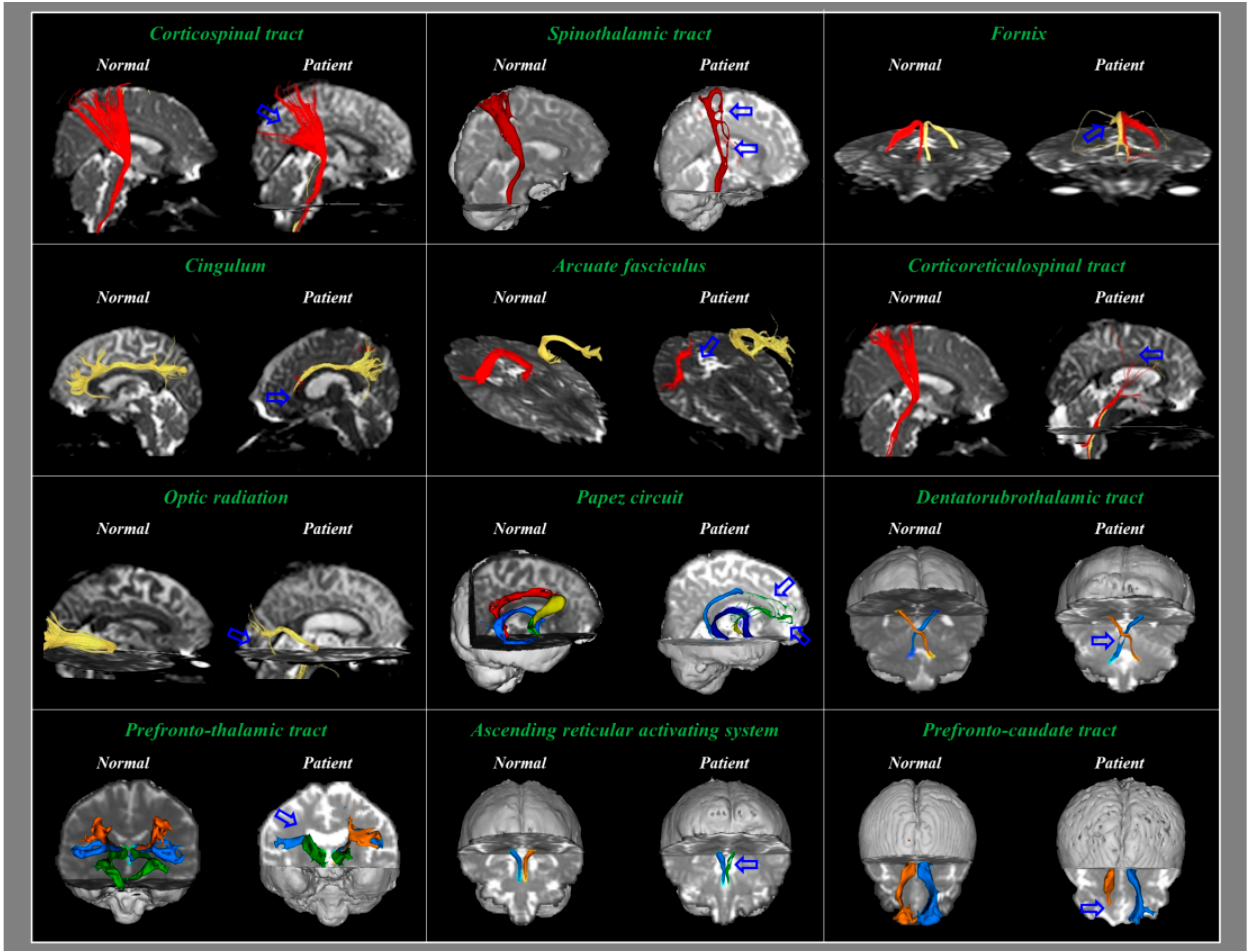
Figure 4. Traumatic axonal injuries (arrow) of various neural tracts (right corticospinal tract, right spinothalamic tract, right fornix, left cingulum, right arcuate fasciculus, right corticoreticulospinal tract, right optic radiation, right Papez circuit, right dentatorubrothalamic tract, right prefronto-thalamic tract, left ascending reticular activating system, right prefronto-caudate tract) in patients with concussion or mild traumatic brain injury (reprinted with permission from [12]).